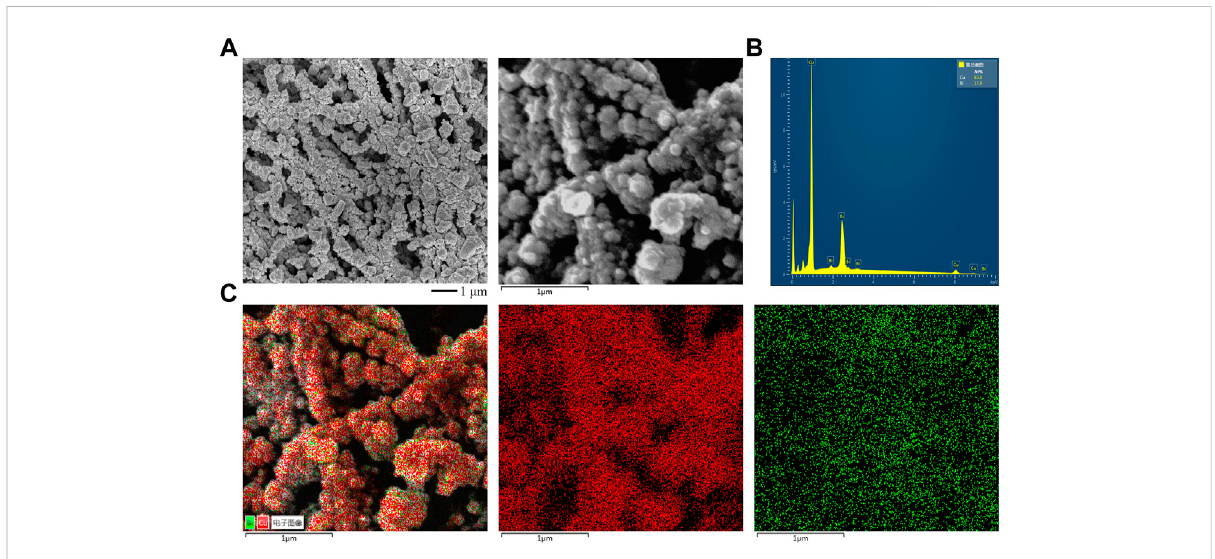
(B) EDX spectrum of the Cu